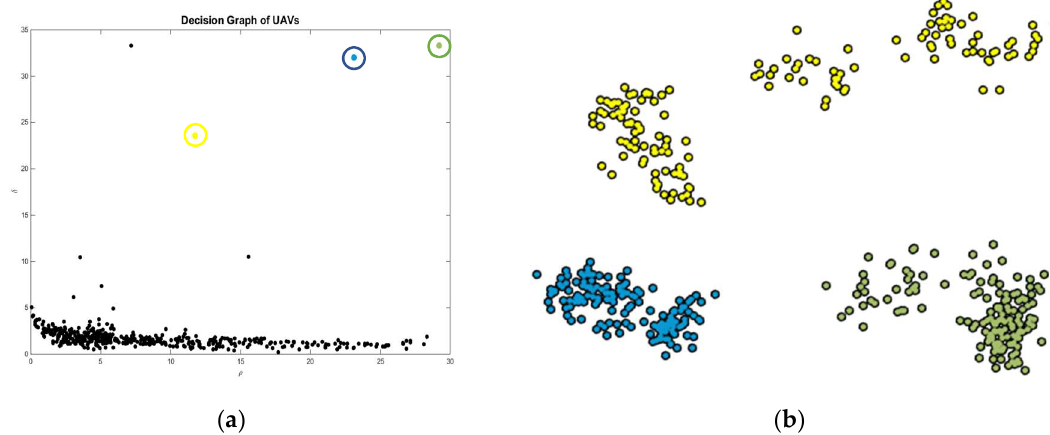
Figure 14. The classification of three targets by CFSFDP with polarimetric decomposition. ( a ) Decision graph of targets; ( b ) Clustering results for three targets. Table 3. The classification accuracy of original algorithms and proposed algorithm with different SNRs.